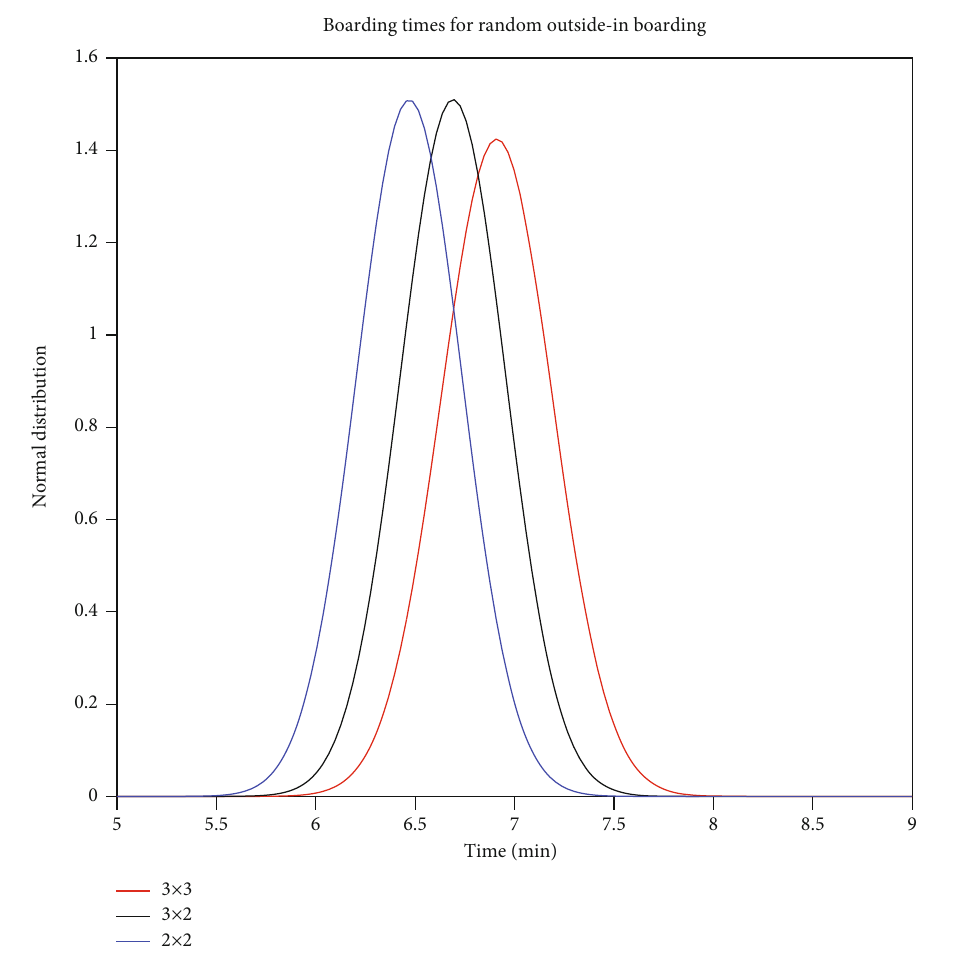
Figure 3: Fitted normal distribution curves for the three aircraft con fi gurations using the random outside-in boarding strategy.